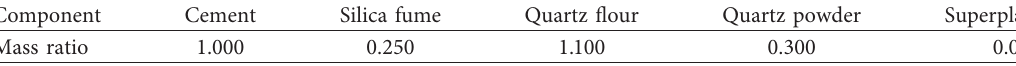
Table 1: Mix proportion of the UHPC matrix.